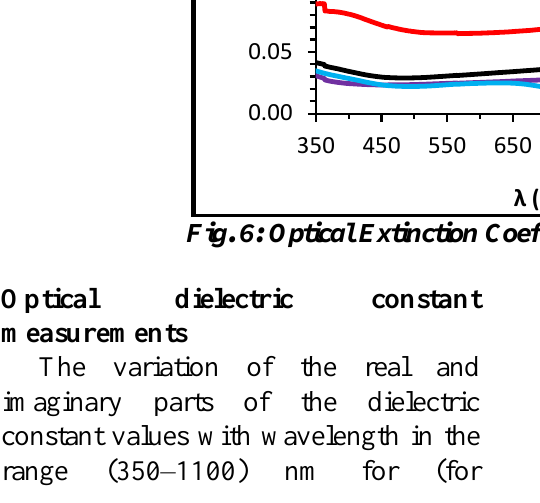
Fig. 6: Optical Extinction Coefficient for V